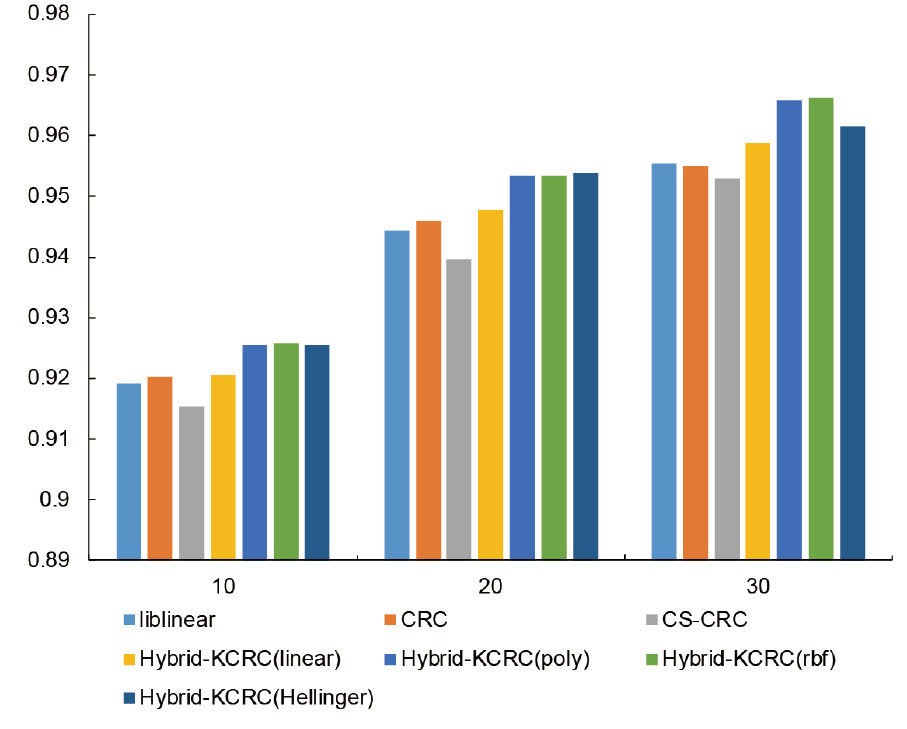
Figure 10. Classification rate on the WHU-RS19 dataset with a different number of training samples in each